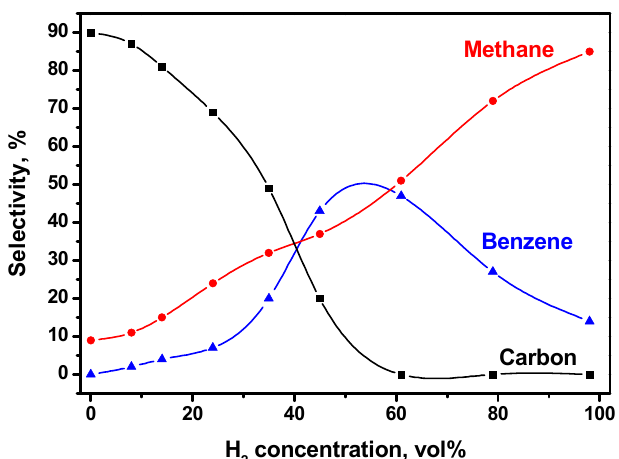
Figure 7. E ff ect of the hydrogen concentration in the H 2 / C 6 H 5 Cl reaction mixture on the selectivity Figure 7. Effect of the hydrogen concentration in the H 2 /C 6 H 5 Cl reaction mixture on the selectivity towards carbon, benzene, and methane over Ni / Al 2 O 3 catalyst at 500 ◦ towards carbon, benzene, and methane over Ni/Al 2 O 3 catalyst at 500 °C. Table 2. Catalytic properties of the Ni/Al 2 O 3 catalyst in the hydrodechlorination of chlorobenzene (CB) at different temperatures and hydrogen concentrations.